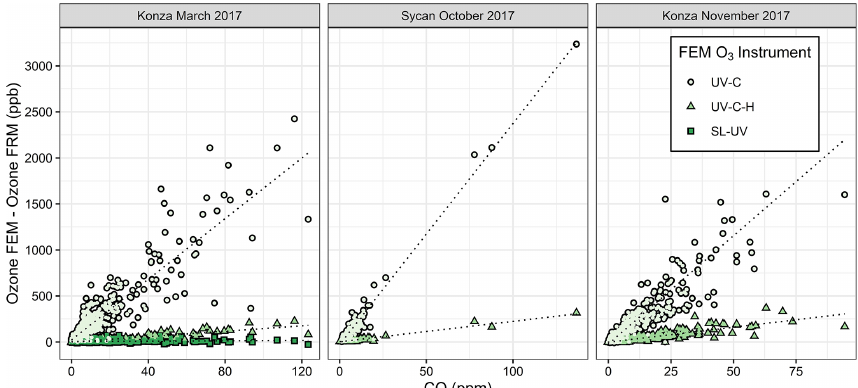
Figure 5. Scatter plots between FEM and FRM O 3 differences and the CO measurements within the grassland fire smoke plumes. The FEM measurements are differentiated by color and shape. The SL-UV method was only run during the Konza March 2017